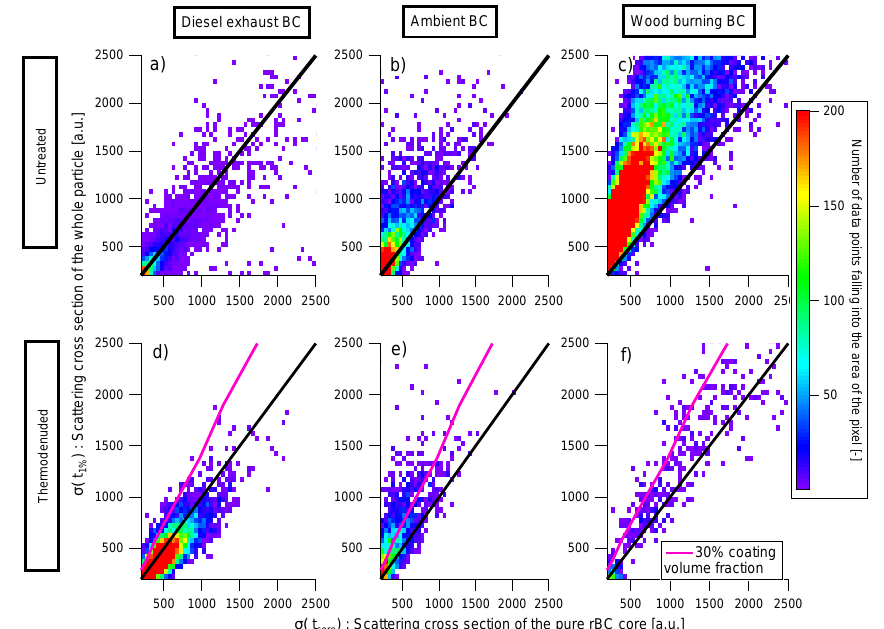
Fig. 4. Estimate of the coating on untreated (top panels) and thermodenuded (bottom panels) samples: diesel exhaust (a, d) , ambient (b, e) , wood burning (c, f) . The data points corresponding to uncoated particles will lie around the one-to-one line while coated particle data points will be shifted above it. The pink lines (copied from Fig. 2) represent the calculated scattering cross sections for 30% coating volume fraction and assuming refractive indices of 2.26+1.26i and 1.5 for BC core and coating, respectively (see Sect.